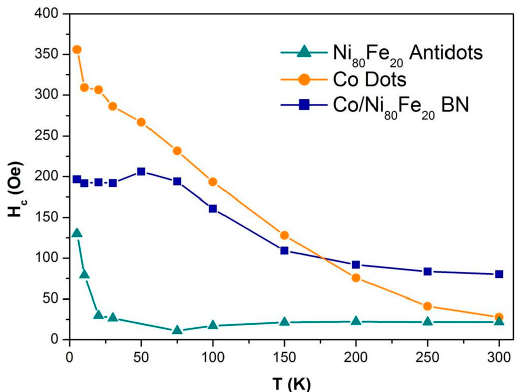
Figure 7. (Colour online) Temperature dependence of the coercive field of Ni 80 Fe 20 antidot arrays, Co dot arrays, and bi-component nanostructured systems.